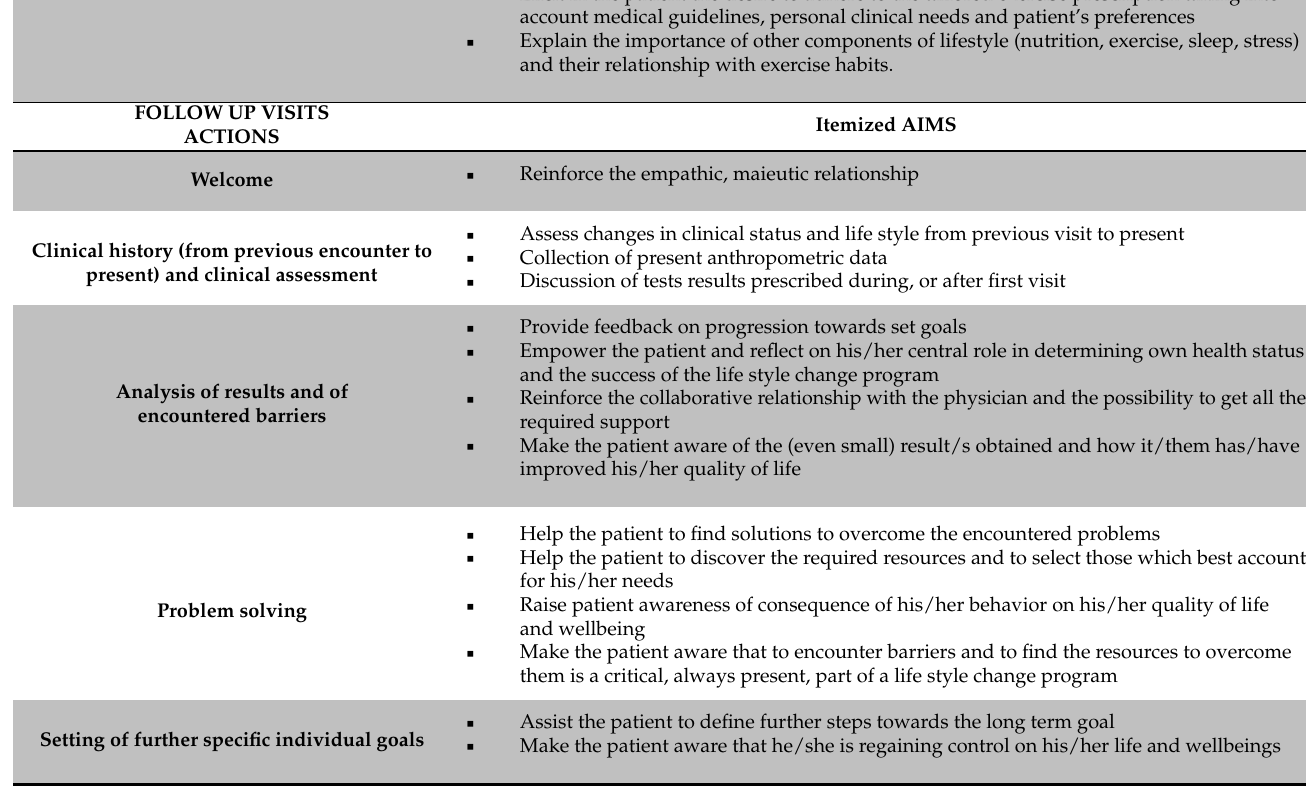
Table 4. Classification of physical activity intensity.